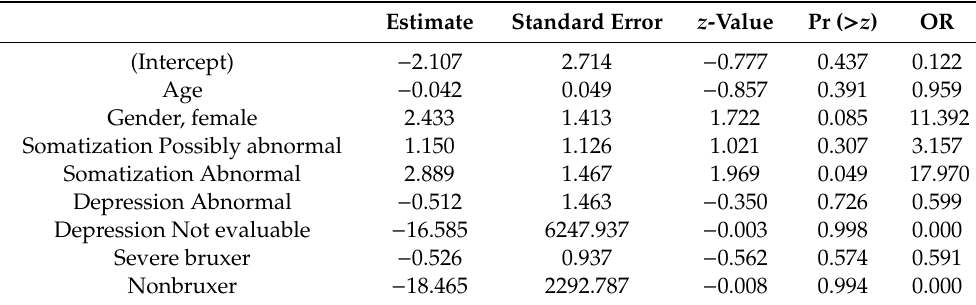
Table 4. Multivariate logistic regression model with RDC / TMD group I (myofascial pain) as the dependent variable. Estimates of the model coe ffi cients.